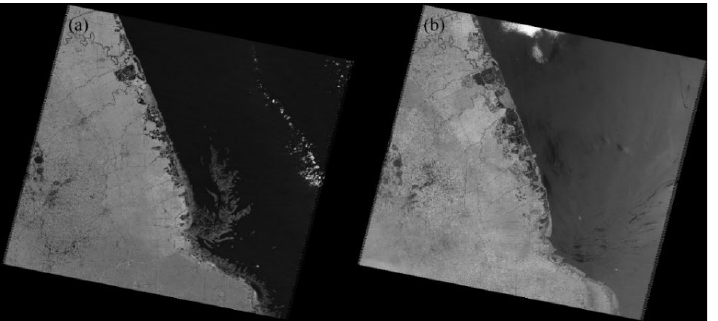
Figure 4. Satellite images acquired by LANDSAT 5 at ( a ) 2:15 UTC on 13 January 2009 and ( b ) 2:18 UTC on 6 June 2009. The images are downloaded from the Geospatial Data Cloud (http://www.gscloud.cn/; accessed on 7 February 2019).